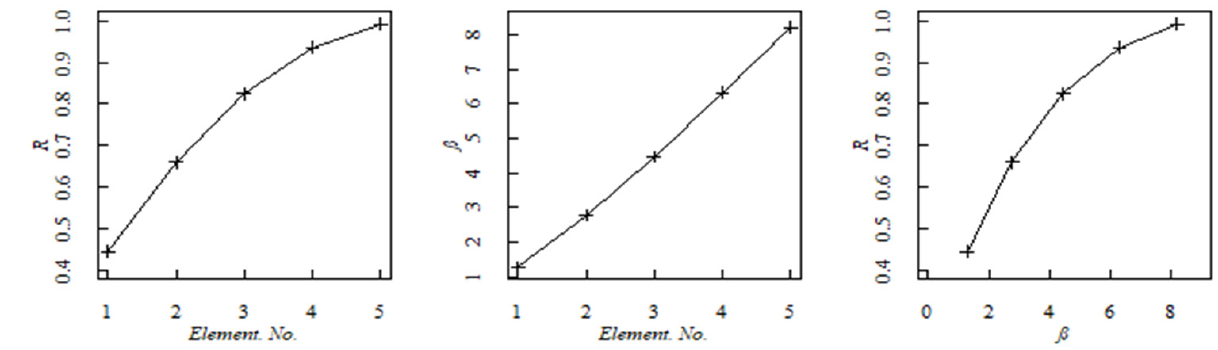
Figure 4. Structural robustness evaluation index ( R ), structural reliability index ( β ), and the fitting curve of the cantilever beam (Left: R vs. Element No. , middle: β vs. Element No. , and right: R vs. β ).